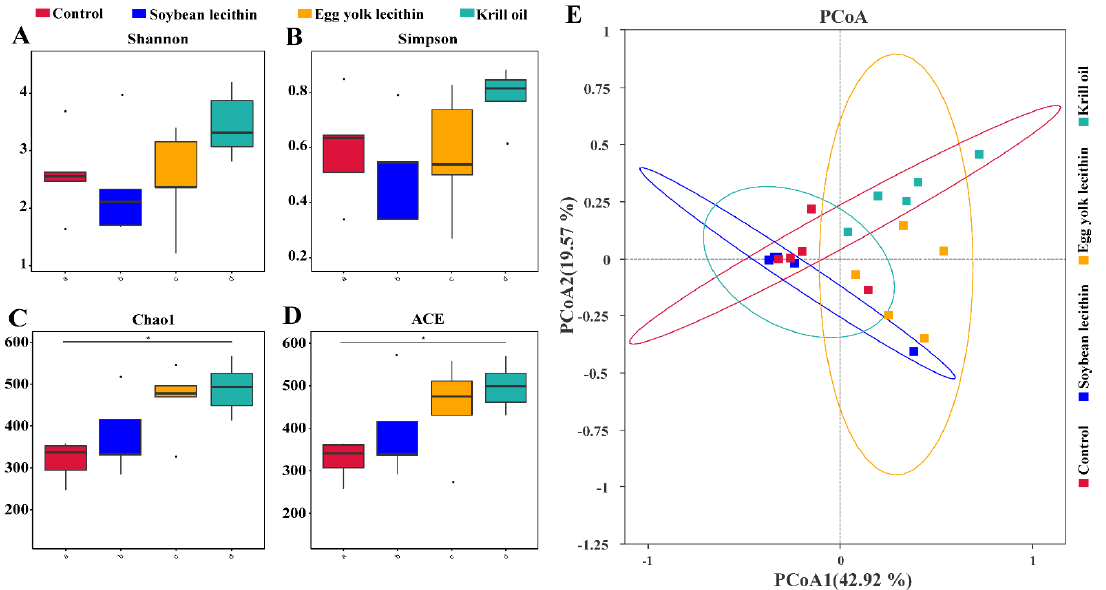
Figure 5. Diversity of gut microbial community of female L. vannamei fed with different phospholipids. Alpha diversity indices of bacterial communities on genus level, ( A ) Shannon, ( B ) Simpson, ( C ) Chao1, ( D ) ACE, the * p < 0.05 indicate significant differences. ( E ) Beta diversity, the principal coordinates analysis (PCoA) performed to evaluate the overall differences in bacterial community structure based on Bray–Curtis distance.